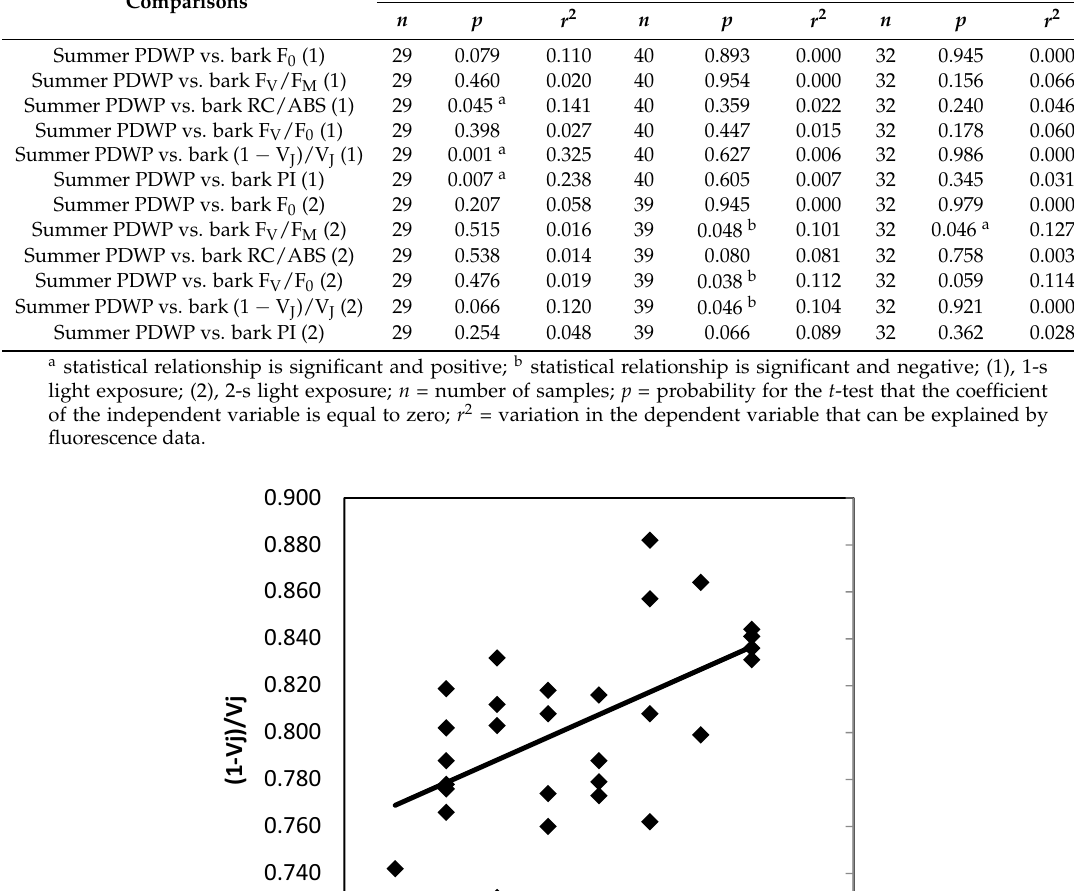
Table 4. Summarized results from simple linear regression analyses comparing summer bark fluorescence with pre-dawn water potentials. Linear regressions using the 95% confidence interval.